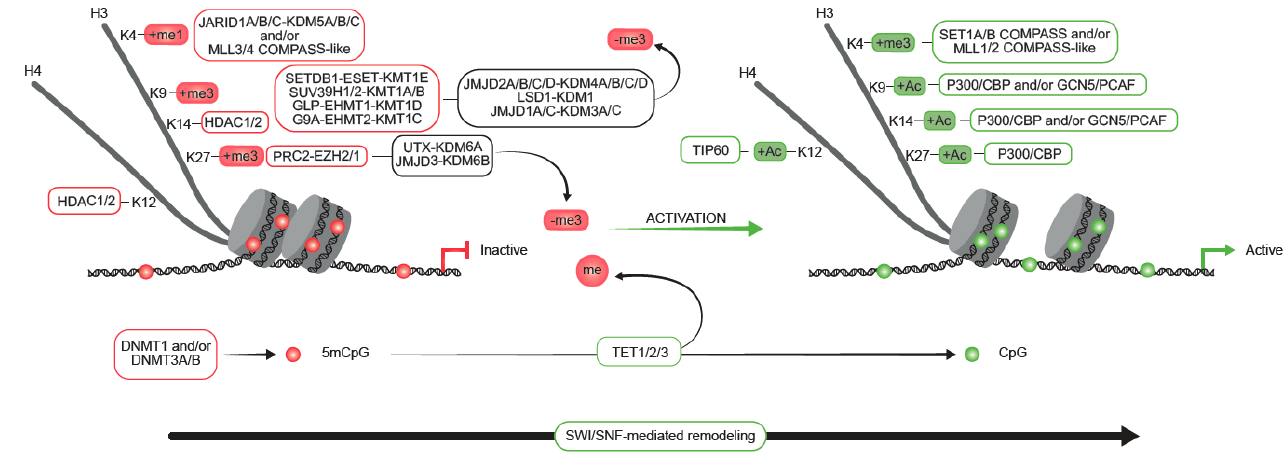
Figure 1. Epigenetic changes during transcriptional activation in mammalian cells. The diagram depicts epigenetic marks associated with transcriptional activation or repression of a gene promoter. Repression-associated epigenetic marks are shown in red (poorly acetylated H4K12 and H3K14, H3K4me1, H3K9me3, H3K27me3 and 5mCpG (for methylated DNA)) and active transcription marks are shown in green (H4K12Ac, H3K4me3, H3K9Ac, H3K14Ac, H3K27Ac, and CpG (for unmethylated DNA)). Enzymes that can mediate deposition (“writers”) and elimination (“erasers”) of these marks are also indicated. The transcriptional start site (TSS) of the gene in active (green) and repressed (red) conditions is also shown. Gray cylinders represent nucleosomes positioned over the promoter region of the active (relaxed disposition) and repressed (compacted disposition) gene.